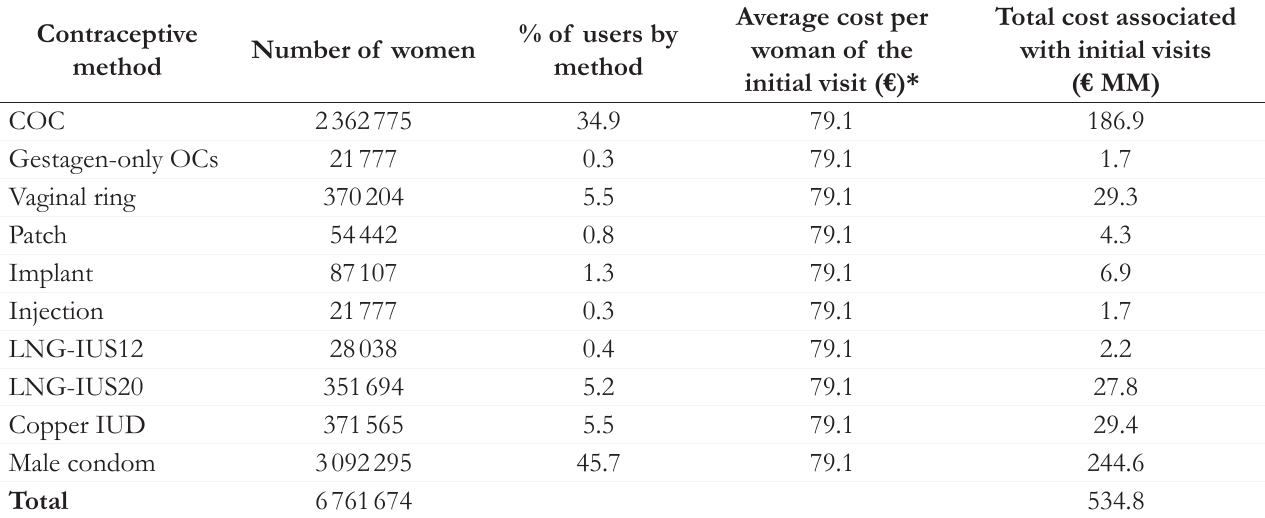
Table 1. Total Cost of the First Consultation with a Gynecologist to Initiate Contraceptive